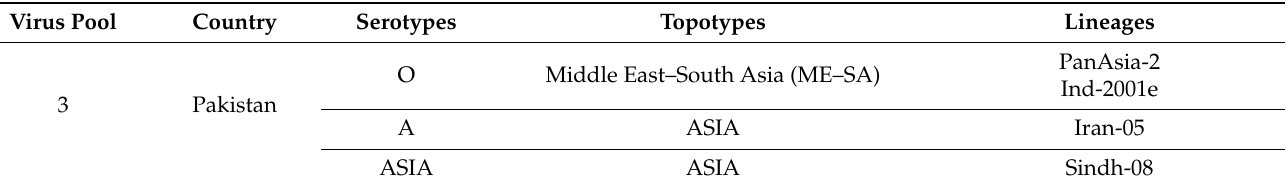
Table 2. FMDV serotypes, topotypes, and their lineages circulating in Pakistan. Virus Pool Country Serotypes Topotypes